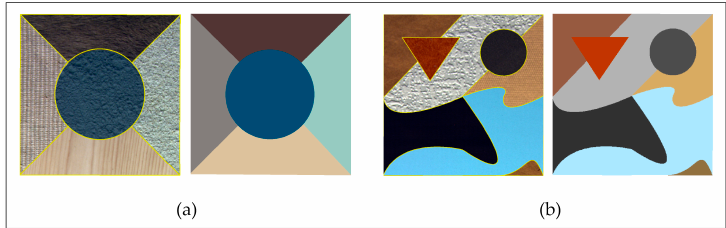
Figure 4. ( a ) The synthetic image S1 and its ground truth; and ( b ) the synthetic image S2 and its ground truth. The object boundaries of reference segmentation on original images are delineated by yellow lines.